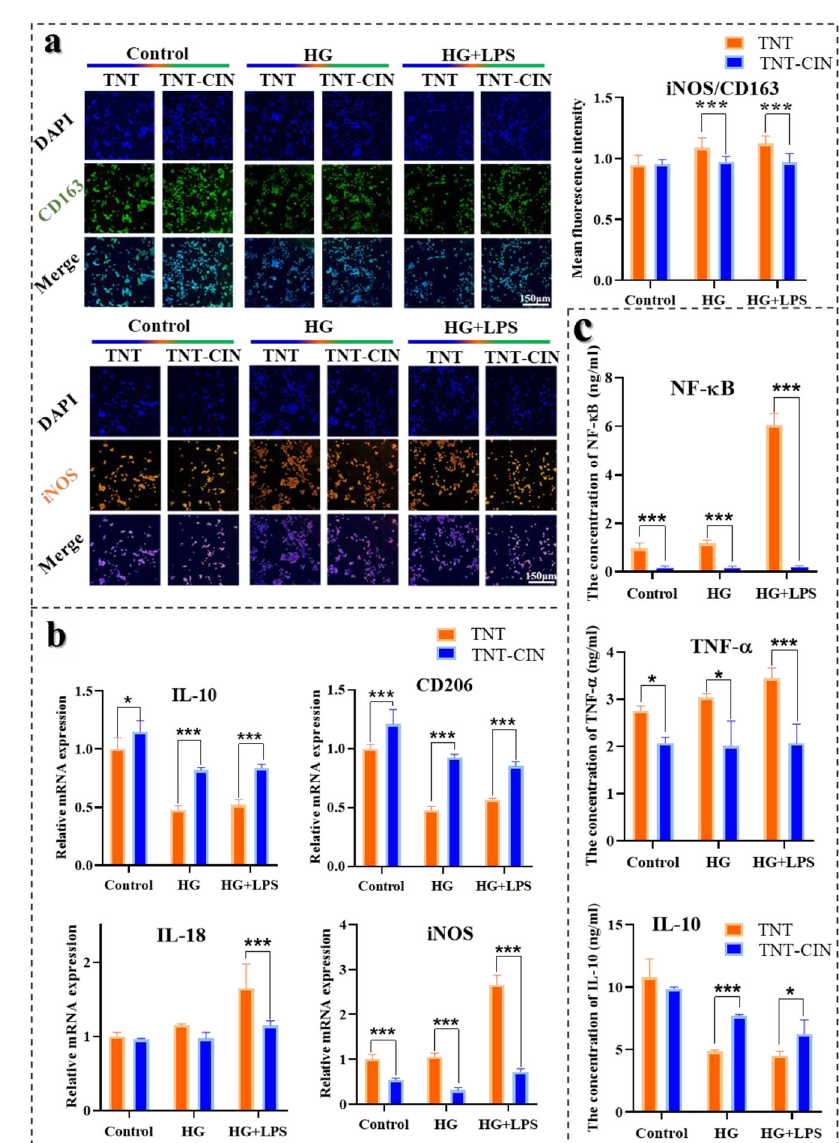
Fig. 5 TNT-CIN induced the polarization of macrophages toward M2 and the secretion of fewer pro-in fl ammatory cytokines and more anti- in fl ammatory cytokines, indicating that TNT-CIN attenuated the in fl ammation caused by HG and PG-LPS. a The immuno fl uorescence staining of iNOS and CD163 observed by confocal scanning laser microscopy after 3 days and its semi-quantitative analysis by Image J. b The expression of relative mRNA under different culture conditions after 3 days. c The secretion of in fl ammatory cytokines under different culture conditions after 3